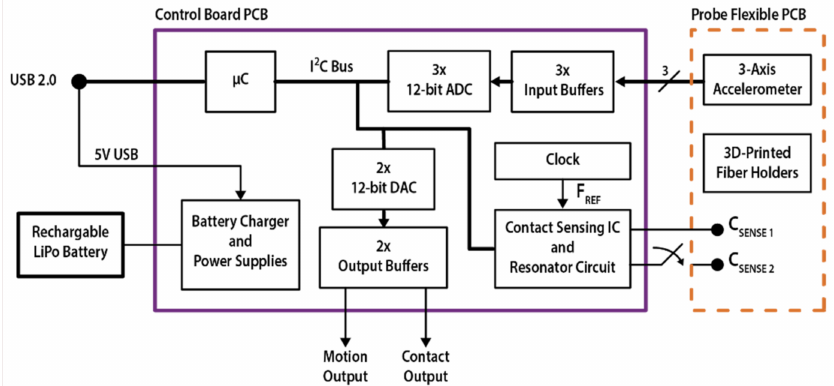
Figure 2. Simplified block diagram of the presented instrument. The optical probe is based on a flexible PCB which incorporates, as well as 3D-printed fiber holders for optical spectroscopy measurements, a 3-axis MEMS accelerometer and an integrated planar capacitive sensor for contact detection. An extremely flexible flat cable connects the probe to the control board where the contact and accelerometer signals are acquired through dedicated front-end circuitry. A microcontroller runs the measurement routine and provides the acquired signal either as digital output through a USB 2.0 link to the external computer or as an analog output through two dedicated signal chains and BNC connectors, allowing for the integration of the device in different measurement setups. A battery management integrated circuit allows for battery operation, reducing the bulk and the hazard risk at the same time, and fostering the adoption of the instrument in clinical